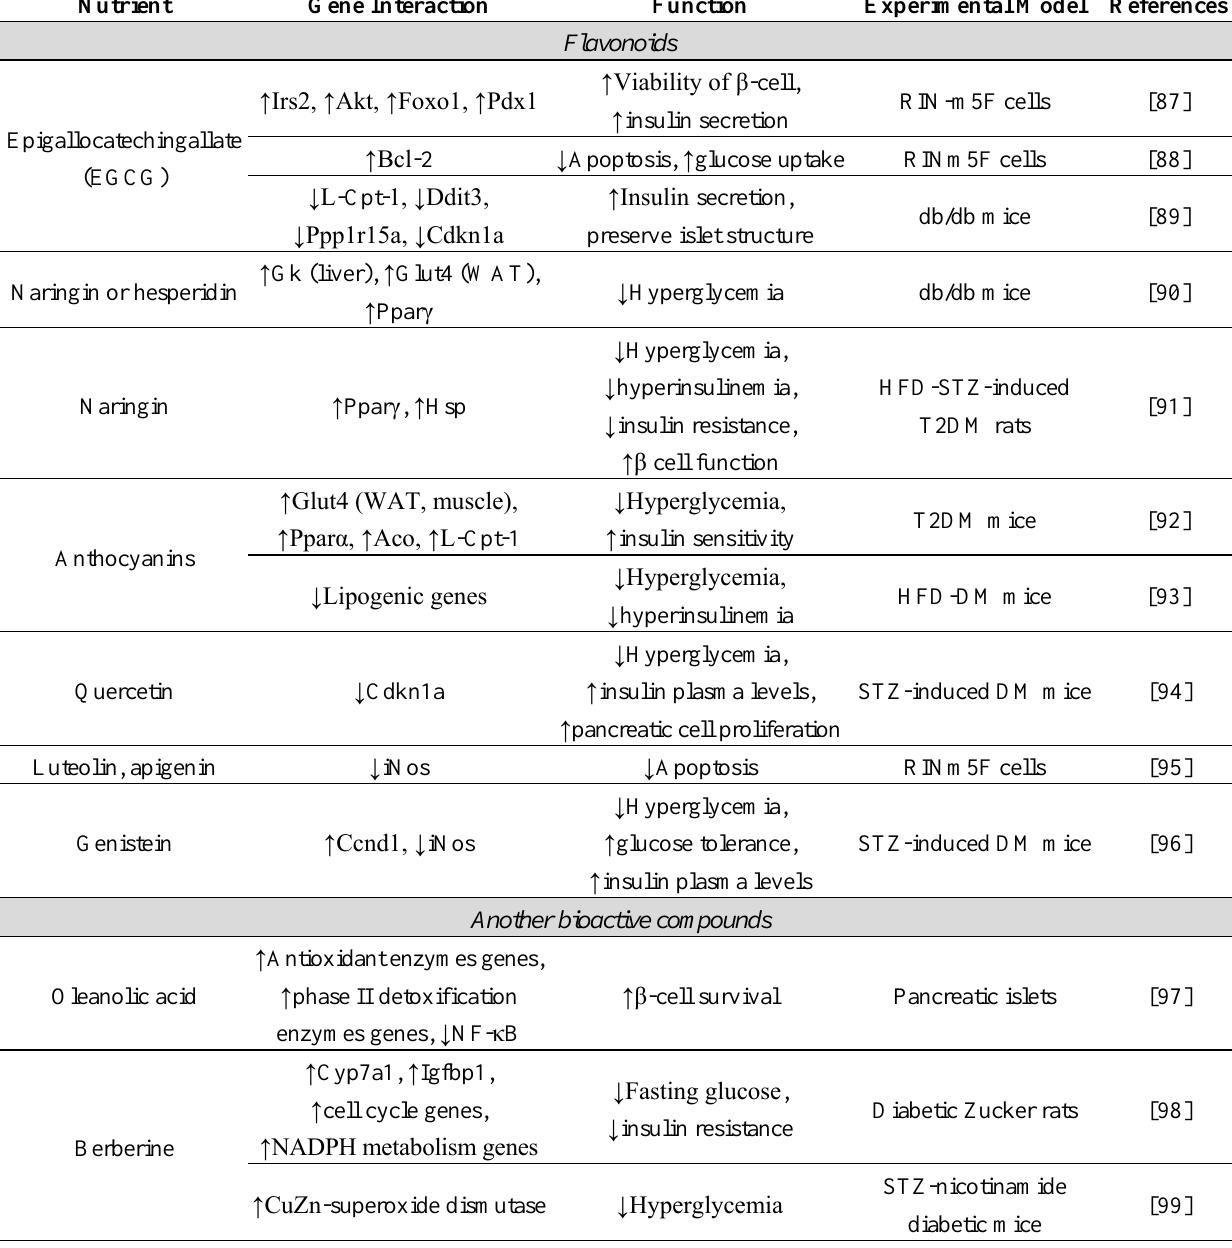
Table 3. Nutrient- or dietary pattern-gene interactions in the development of